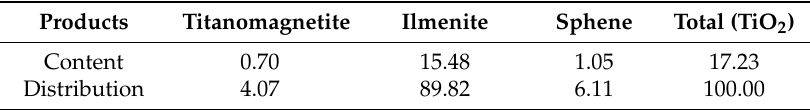
Table 4. Phase analysis of titanium